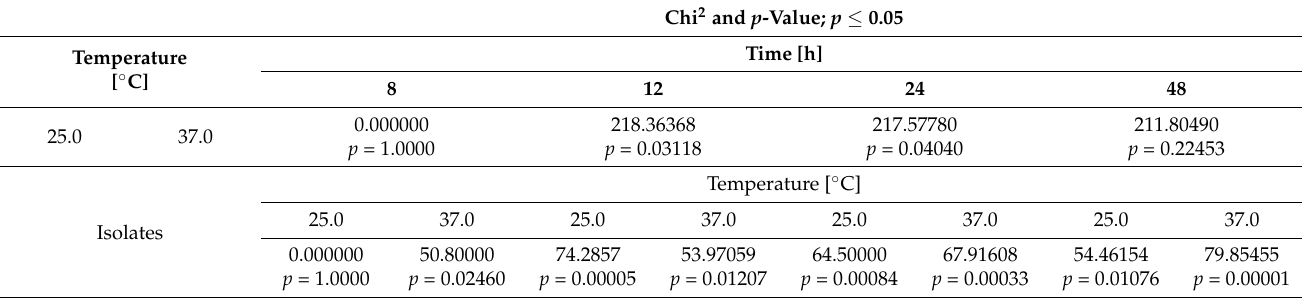
Table 3. Influence of temperature and time on biofilm formation by tested bacterial isolates.